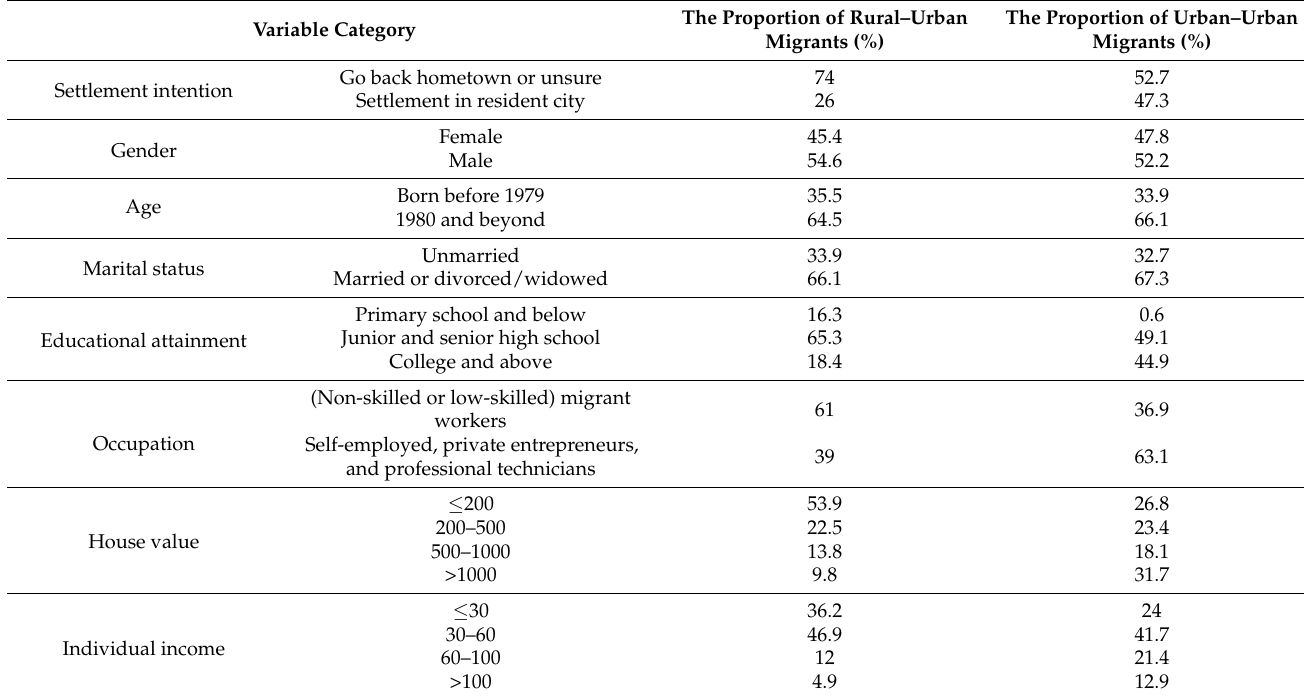
Table 4. Settlement intention and individual characteristics of rural–urban migrants and urban–urban migrants.